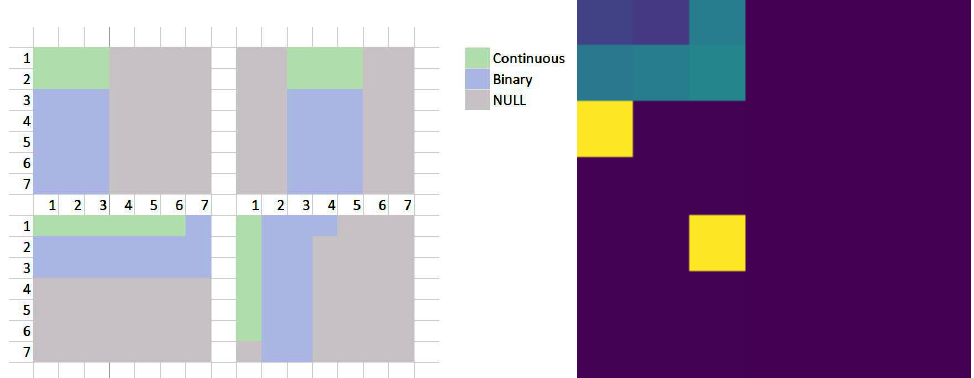
Figure 4. ( Left ) Possible Thyroid’s features arrangements. ( Right ) Sample from the Thyroid’s database converted into an